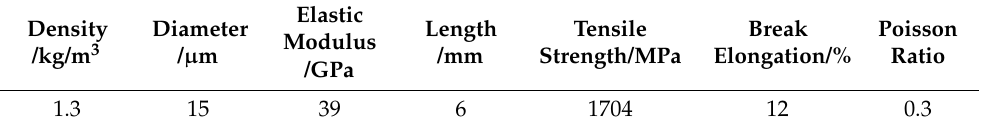
Table 4. Basic performance index of PVA